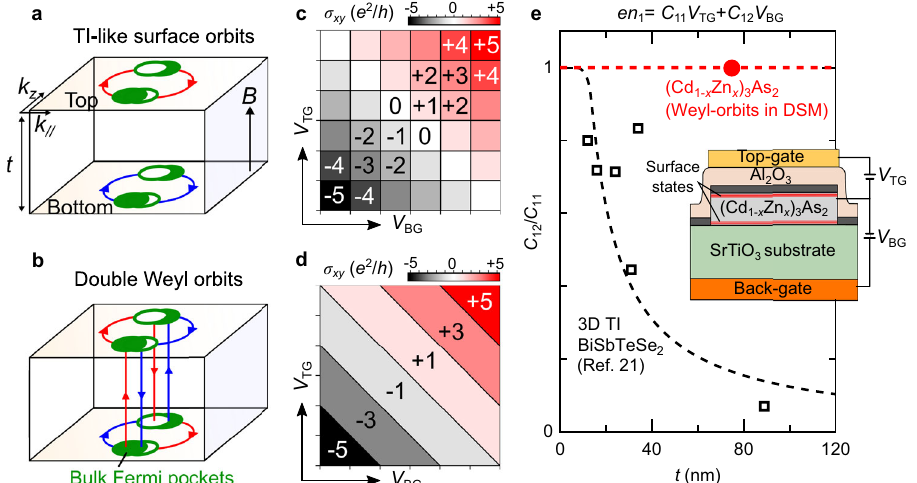
Fig. 1 Quantum Hall signature of topological surface orbits. a Conventional topological-insulator-like (TI-like) surface orbits independently localized on each fi lm surface. b A pair of Weyl orbits connecting the top and bottom surface states via the bulk chiral modes. c , d Expected appearance pattern of quantum Hall states for TI-like surface orbits ( c ) and for doubly degenerate Weyl orbits ( d ) in a Dirac semimetal fi lm. e Capacitive coupling of carrier density for each surface orbit ( n 1 , n 2 ) to the top and back-gate voltages ( V TG and V BG ) as de fi ned in Eq. (3). While the two surface orbits in the TI-like case are decoupled and C 12 / C 11 decreases to 0 as the fi lm thickness t increases 21 (black dashed line), the carrier density of the paired Weyl orbits is expected to be modulated simultaneously by both V TG and V BG ( C 12 / C 11 = 1) independent of the fi lm thickness (red dashed line). The inset is a schematic illustration of the dual-gate con fi guration fabricated on the (Cd 1 − x Zn x ) 3 As 2 fi lm, where electrons are depleted when V TG ( V BG ) <